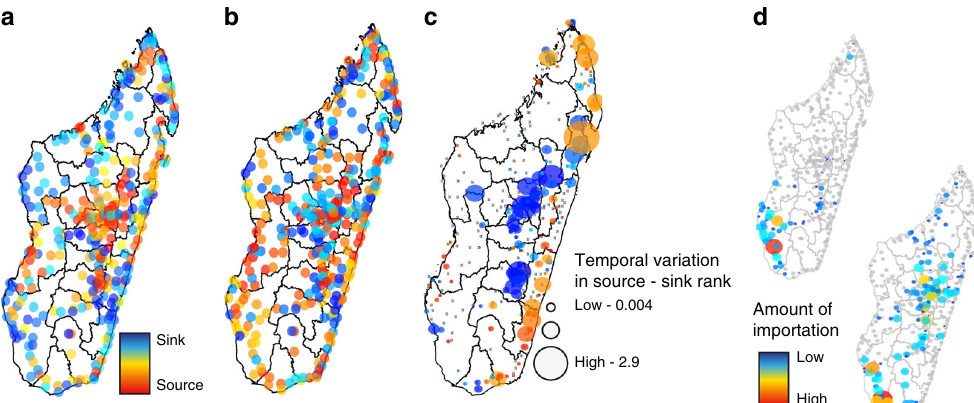
Fig. 4 The sources and sinks of travel and parasite movement. We identi fi ed locations that were primarily sources versus sinks of a travel and b parasite movement for all communes included in the analysis. Sources and sinks of travel were geographically nearby, in contrast to the primary sink of parasites in the central highlands. c The temporal variability (coef fi cient of variation) in the source vs. sink rank over the time series of the data highlighting the most variable source and sink locations were along the East coast and in the central Highlands. d For two sample communes, Ampanihy and Betioky Sud, in the coastal region in Atsimo-Andrefana, the sink destinations are shown (locations with no importations are shown in grey). These two communes are similarly ranked sources. However, they differ both in terms of the number of sink locations and magnitude of importations at each sink location, suggesting that a more re fi ned estimate of importation may be necessary to assess the impact of targeted